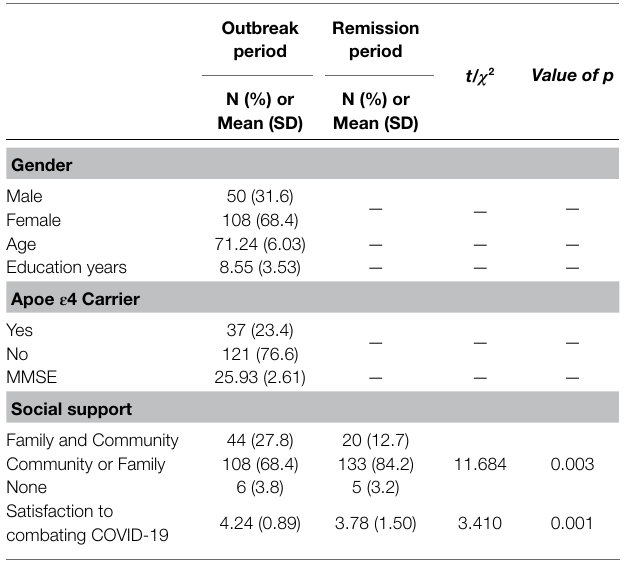
TABLE 2 | Participant characteristics at outbreak and remission periods of COVID-19 pandemic ( N = 158).